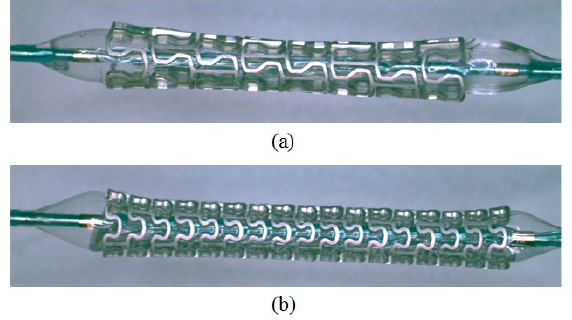
Figure 15. Dog-boning phenomenon of ( a ) Stent B and ( b ) Stent C at the start of expansion.